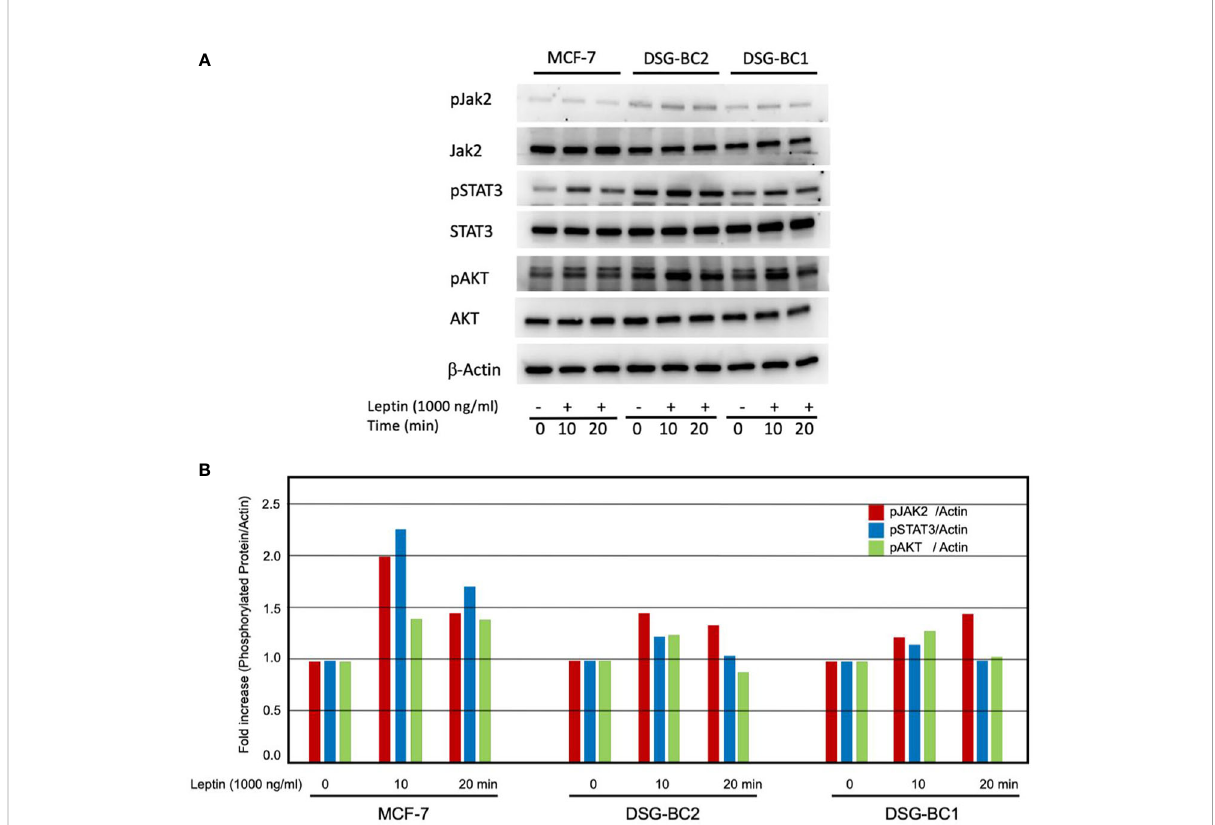
FIGURE 11 Western blot analysis revealed rapid activation of the JAK/STAT3/AKT signaling pathway in response to leptin both in DSG-BC-1 and DSG-BC-2 breast cancer cell lines. Cells (4 × 10 5 ) were plated in six-well plates. After 24 h, cell extracts were prepared at the indicated time points (0, 10, and 20 min) of leptin stimulation (1,000 ng/ml), as described in Materials and methods . (A) Total cell extract (30 m g) was separated in 7.5% SDS- PAGE. Western blot analysis for total JAK2 and phosphorylated JAK2 (pJAK2), total STAT3 and phosphorylated STAT3 (pSTAT3), and total AKT and phosphorylated AKT (pAKT). (B) Histogram of the normalized signals of the indicated phosphoproteins of the panel (A) Phosphoprotein signals were corrected with the signal of beta actin ( b -actin); images were digitalized and analyzed using the public ImageJ